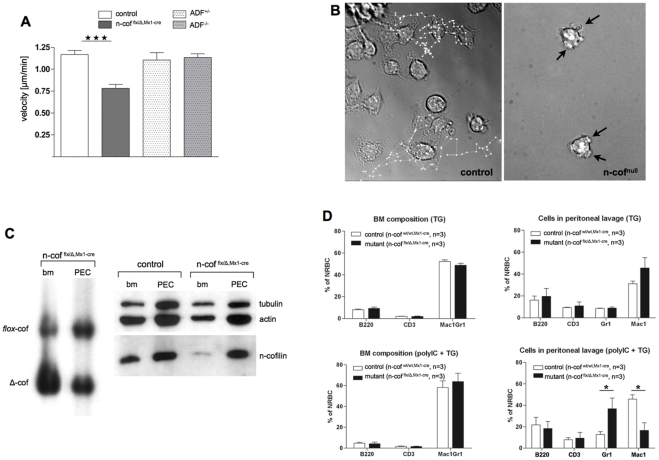

In vitro and in vivo migration of macrophages lacking n-cofilin.(A) Random motility of n-cofnull BMM is impaired, ADF−/− macrophages behave normally. Velocity of center movement over a period of 20 min is shown (ncells>60, student's test n-cofnull:control p<0,0001); (B) Over a period of 8 hours n-cofnull cells show no significant net translocation, cell protrusions collapse back onto the cell body (see arrows). Migratory tracks are shown by white lines and dots, for two cells each (see also videos S1, S2, S3); (C) In vivo recruitment of n-cofnull cells to sites of inflammation is impaired. Thioglycollate injection (TG) into n-cofflx/Δ,Mx1-cre mice does not lead to recruitment of mutant macrophages (Δcof) to the peritoneum (PEC). N-cofilin depleted cells remain in the bone marrow (bm). Southern blot of the respective mutant cell fractions (n-cofflx/Δ,Mx1-cre) is shown in the left panel, and the corresponding western blot in the right panel. PEC mainly consists of escaper cells as indicated by the equal Δcof/flox-cof signals in Southern blot and the presence of n-cofilin protein. Western blot analysis of control mice (n-cofwt/wt,Mx1-cre), is shown on the right panel to illustrate the normal expression levels of n-cofilin in bm and PEC under these conditions; (D) FACS analysis of bone marrow (bm) and PEC from the experiment in (C). Bone marrow composition after TG injection (TG) and n-cofilin deletion (poly(I−C)+TG) was comparable (left panels). The main portion of bm cells were Mac1/Gr1 positive, few B cells (B220) and T cells (CD3) were detected. By FACS the Mac1 and Gr1 positive cells in bm appear as one population. 3 days after TG treatment, the majority of PECs in controls are positive for the macrophage marker Mac1 (upper right panel). Upon deletion of n-cofilin (poly(I−C)+TG), the PEC population increases in Gr1 (granulocytes) and decreases in Mac1 (macrophages).